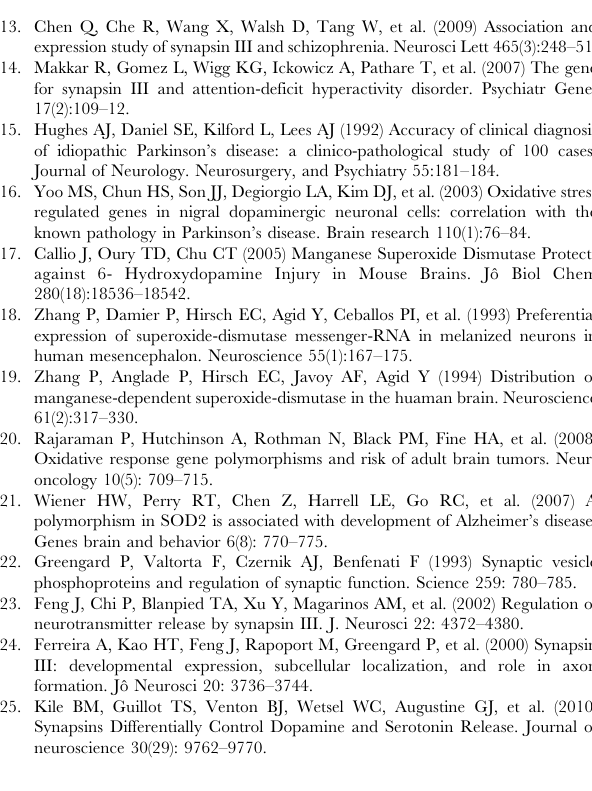
Table S1 The demographic data of the studied popula- tions.